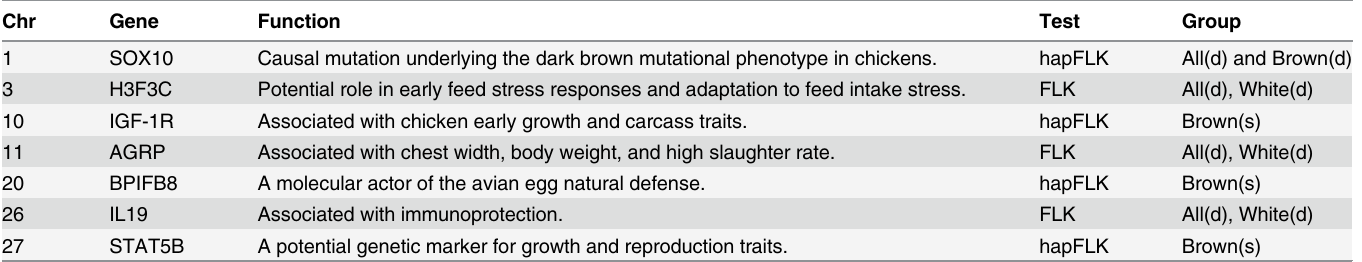
Based on the hapFLK values distribution, a total of 41 regions (17 in all layers, 12 in white lay- ers and 12 in brown layers) were detected as selection signatures (S8 Table). All these regions were in either the upper or the lower 0.05% of the distribution, which represent regions with a fixed difference or fixed similarity between populations, respectively. The genome-wide distri- bution of hapFLK values with 5 haplotype clusters obtained for each group — all, white and brown — are depicted in Fig 3A, 3B and 3C, respectively. Annotation was carried out for all regions with extreme hapFLK values, i.e. potential selective sweeps. The lists of genes for selec- tive sweeps detected with hapFLK are available in the supplementary tables (S9, S10 and S11 Tables). The annotation list is enriched with genes of biological interest involved in various pathways such as nerve development (p = 0.027), growth factor receptor (p = 0.008), RNA met- abolic process (p = 0.042) and skeletal muscle cell differentiation (p = 0.032), all of which could be related to production traits indirectly. The lists of pathways and gene ontologies under which were detected under selection in this study are available in the supplementary tables (S12, S13 and S14 Tables). We identified four genes that were related to the breeding goals of chickens with the hapFLK method. IGF-1R and STAT5B are associated with growth and car- cass traits [37,38]. BPIFB8 and SOX10 , which are associated with egg natural defense [39] and dark brown mutational phenotype [40] respectively (more details is available in Table 2). Sev- eral QTL, which were related to the breeding goals of egg-layer chickens were detected as well, Table 2. Genes associated with productive traits in FLK and hapFLK analysis in all three studies. ‘ All ’ , ‘ White ’ , and ‘ Brown ’ stand for inclusion of all the commercial breeds, analysis within white layers and analysis within brown layers, respectively. ‘ s ’ stands for similarity and ‘ d ’ for